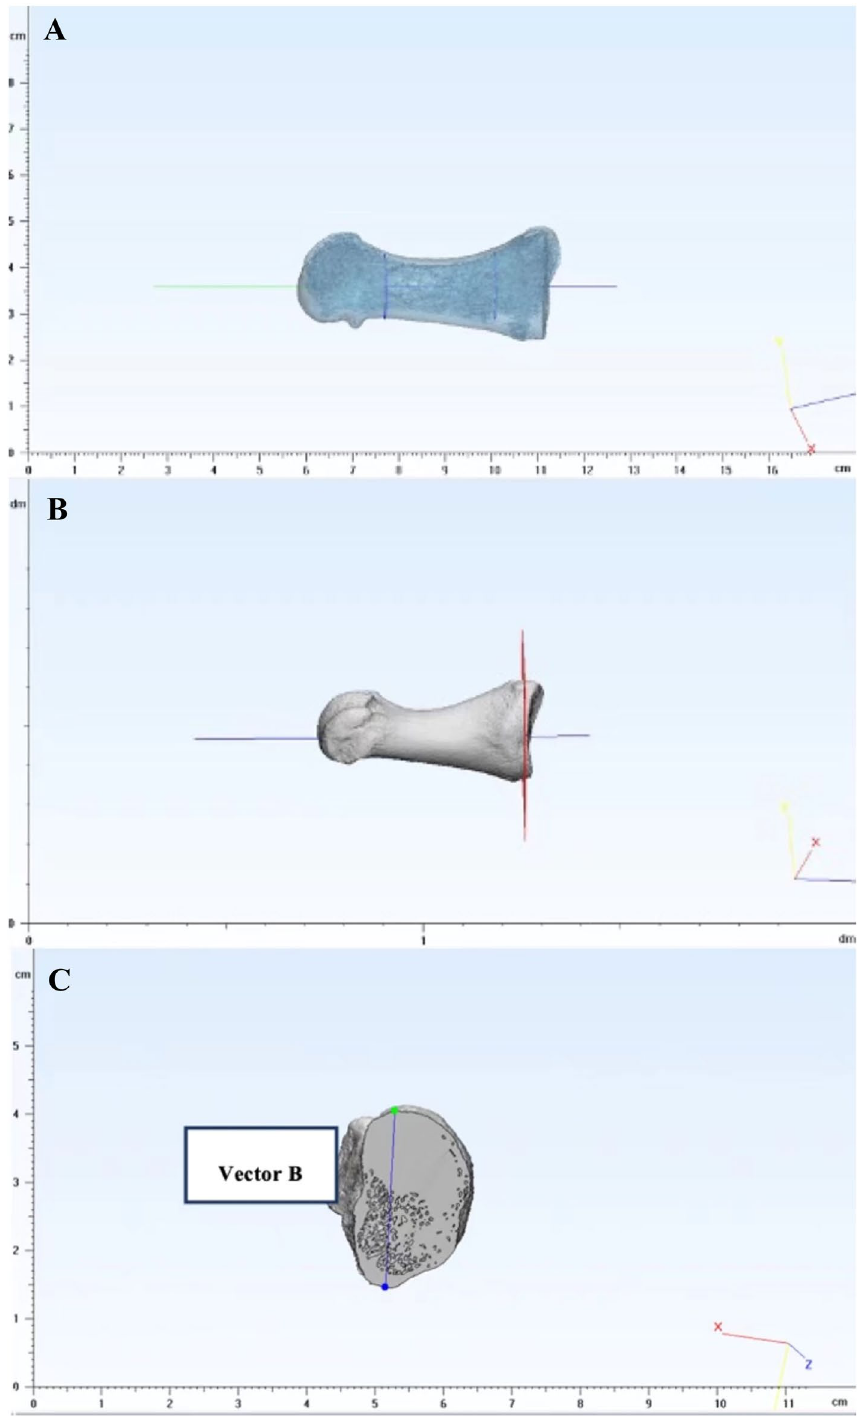
Figure 5. ( A ) A fitting cylinder of the diaphysis was created. ( B ) A cross-section beneath the articular surface was extracted. ( C ) Vector B was created by connecting the most superior and inferior